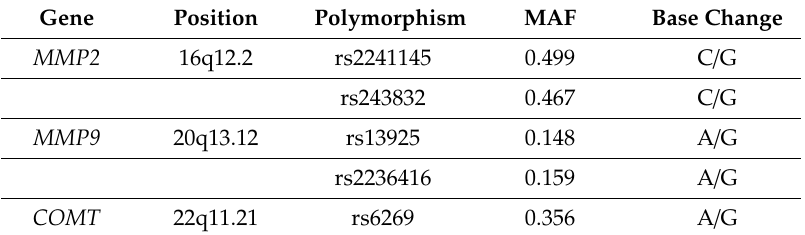
Table 1. Genes and polymorphisms